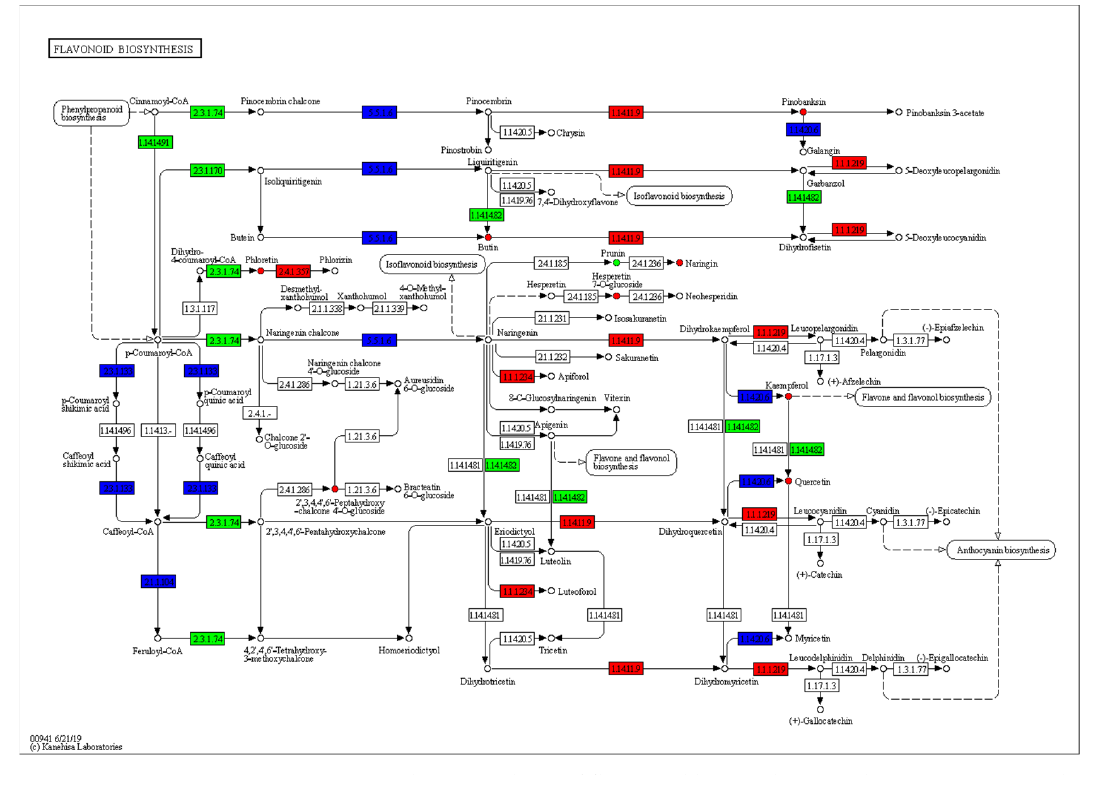
Figure 9. KEGG pathway analysis of flavonoid biosynthesis pathway. From top to bottom, Y vs. LP, Y vs. YP, Y vs. P.